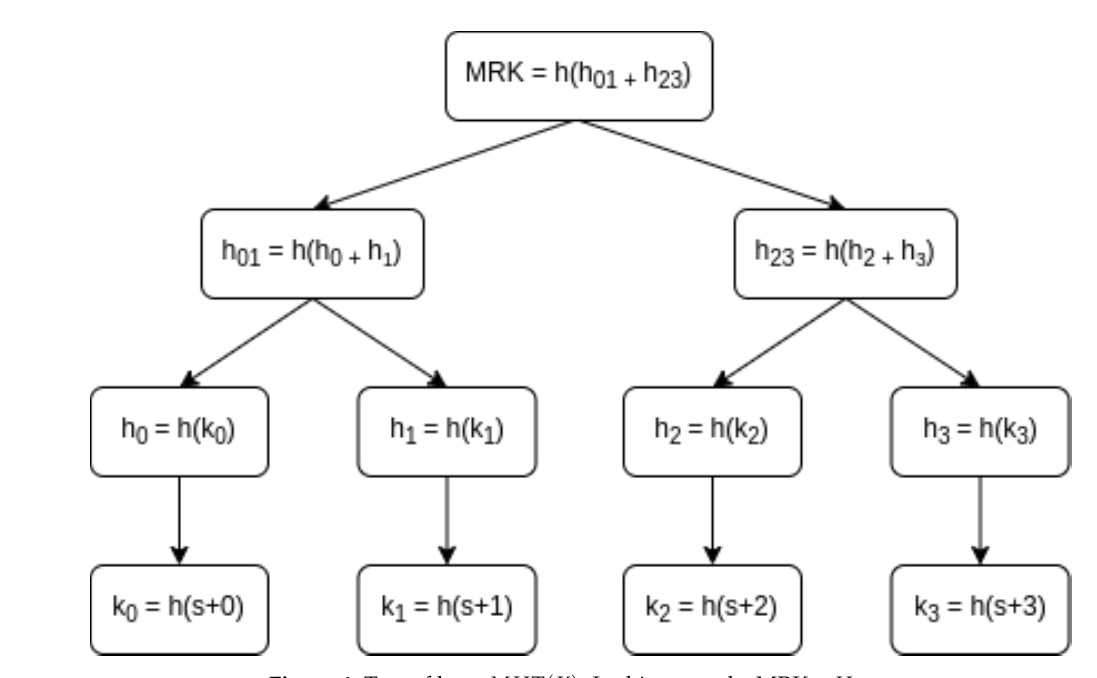
Figure 4. Tree of keys MHT ( K ) . In this example, MRK = H 0123 .